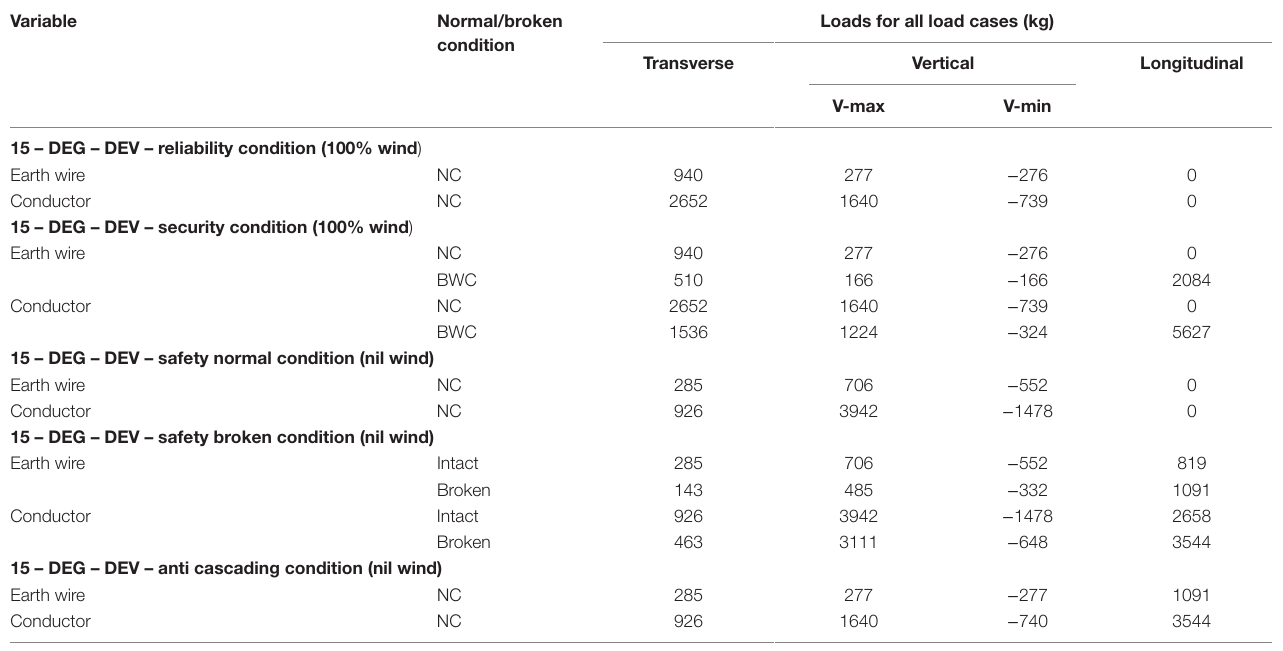
TaBle 2 | summary of input loading for analysis of transmission tower.